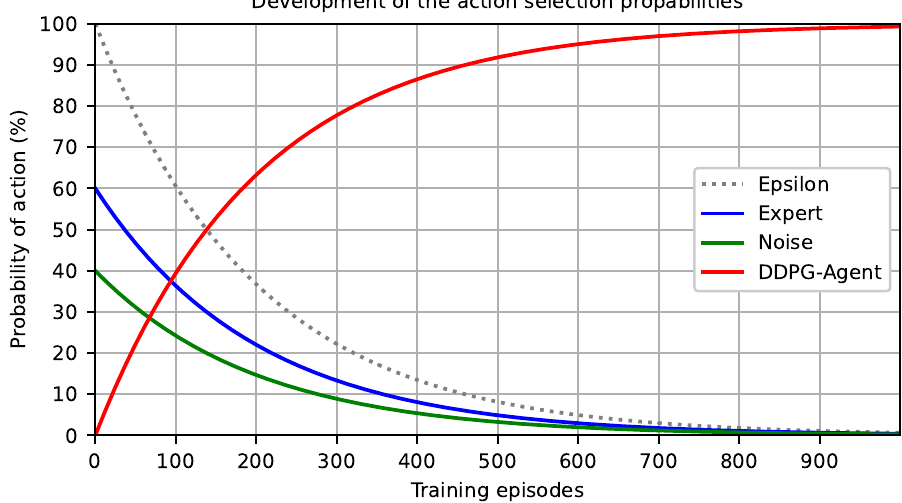
Figure 5. Distribution of the action probability from expert